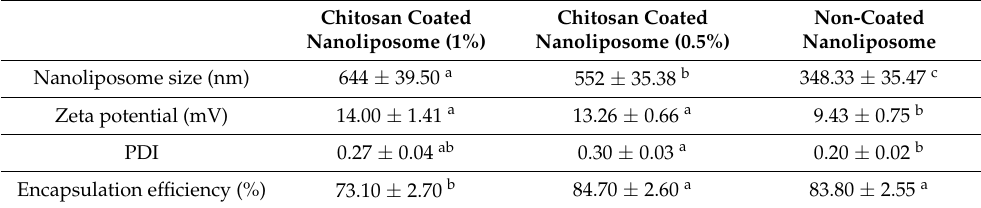
Table 1. Particle size, zeta potential, PDI, and microencapsulation efficiency of nanoliposomes containing 14% hydrolyzed